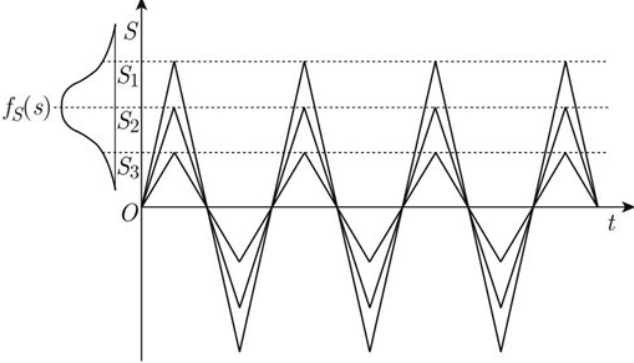
Figure 1. Uncertainty constant amplitude cyclic load.